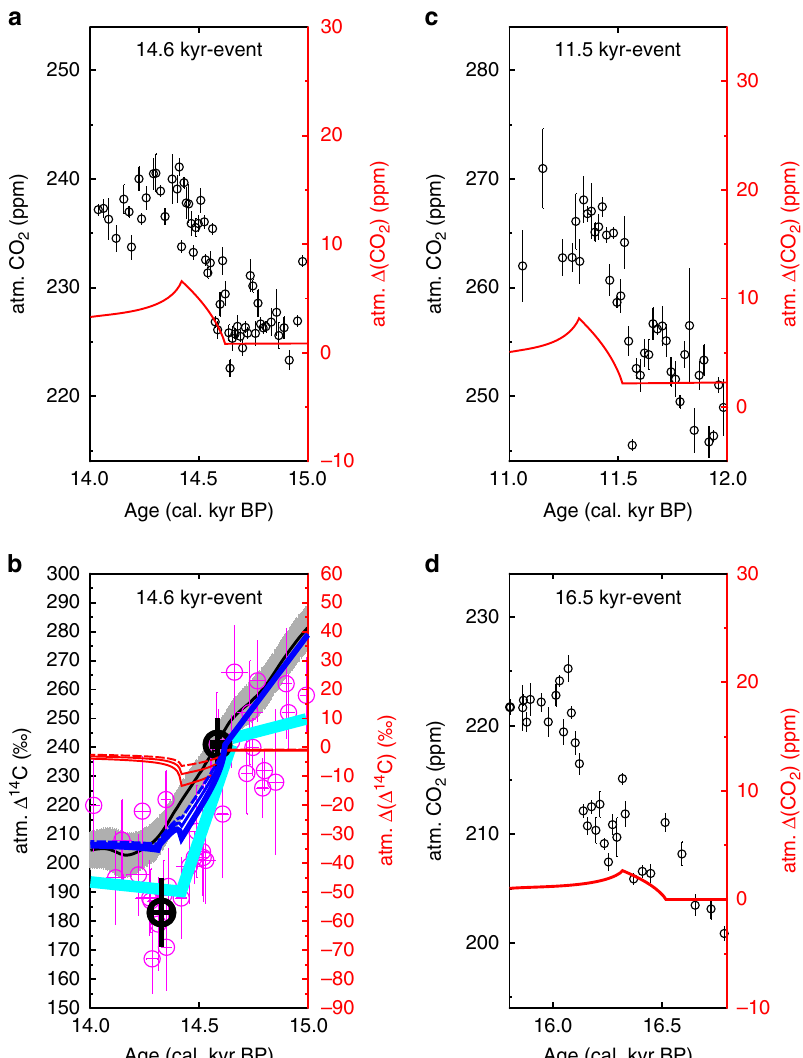
Fig. 5 Zoom-in on proposed 3 events of coastal erosion-based carbon cycle changes. CO 2 changes for a 14.6 kyr-event, c 11.5 kyr-event, d 16.5 kyr-event. Circles are CO 2 data from ice cores (refs. 12,13 , data as in ref. 69 ). b Radiocarbon impacts during 14.6 kyr-event. IntCal13 (black with grey uncertainty band). High-resolution U/Th-dated Δ 14 C from Tahiti corals (magenta) 31 . Linear change in the Tahiti-based data 14 C calculated with the Break fi t software (cyan bold line) 70 and mean of Tahiti Δ 14 C data before and after break (bold black circles). Simulated Δ ( Δ 14 C) based on 5 (red broken) and 10 (red thin)